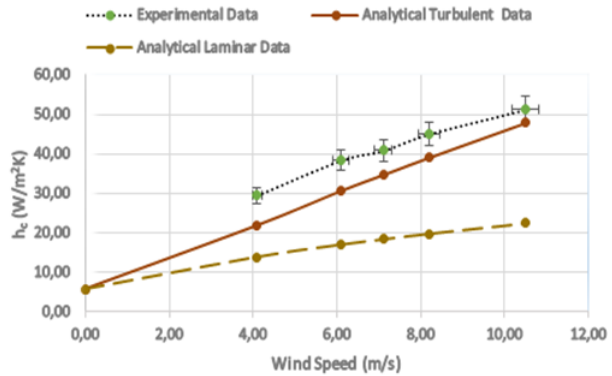
Fig. 7. Convection heat transfer coefficient according to wind